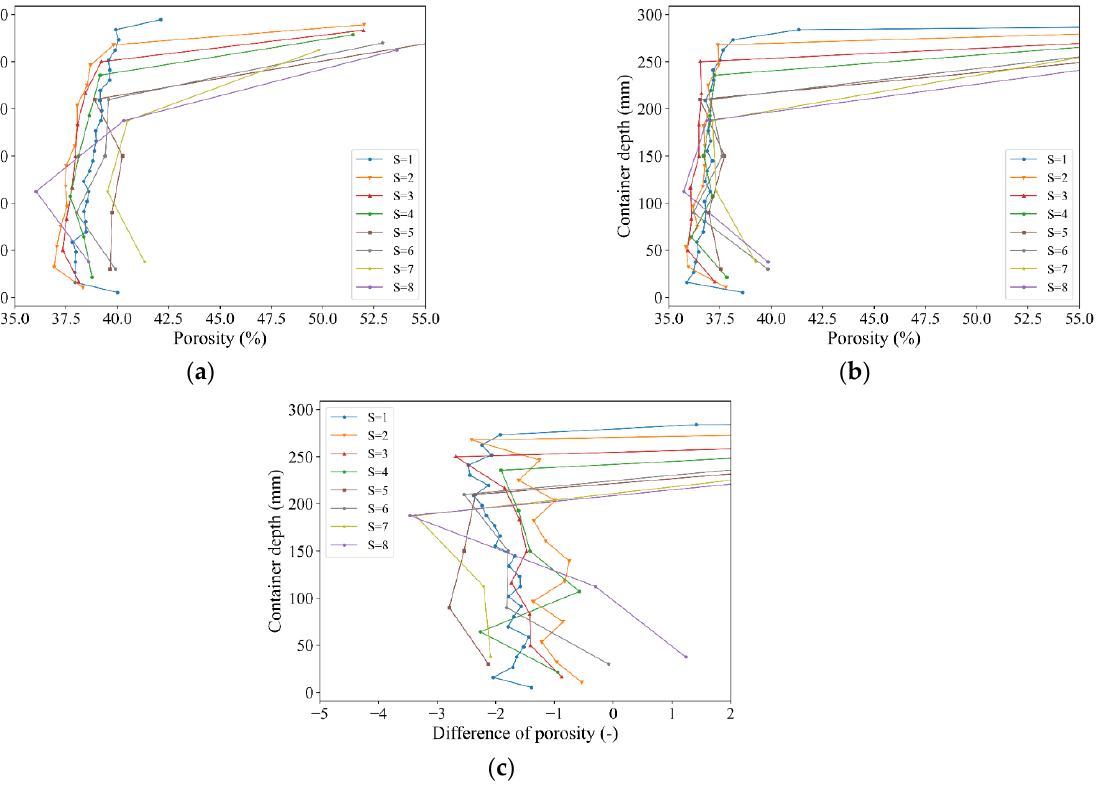
Figure 5. Porosity distribution. ( a ) Before vibration; ( b ) After vibration; ( c ) Difference of porosity after and before